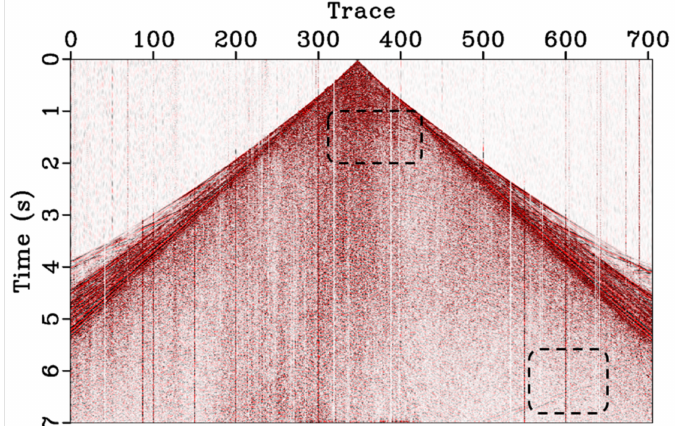
Figure 12. Land field data. Dashed box is follow-up the zoom contrast section.